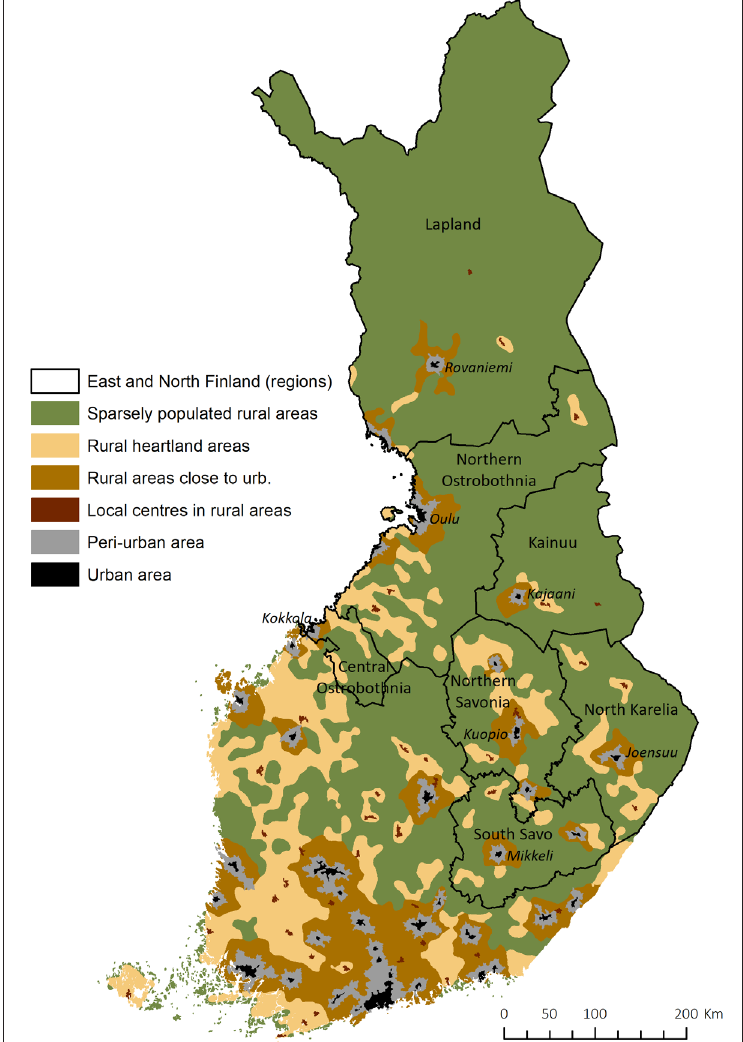
Fig. 1. Spatial structure of the regions ( maakunta ) and regional centres of East and North Finland. (Data sources: SYKE 2013; NLS & Ek